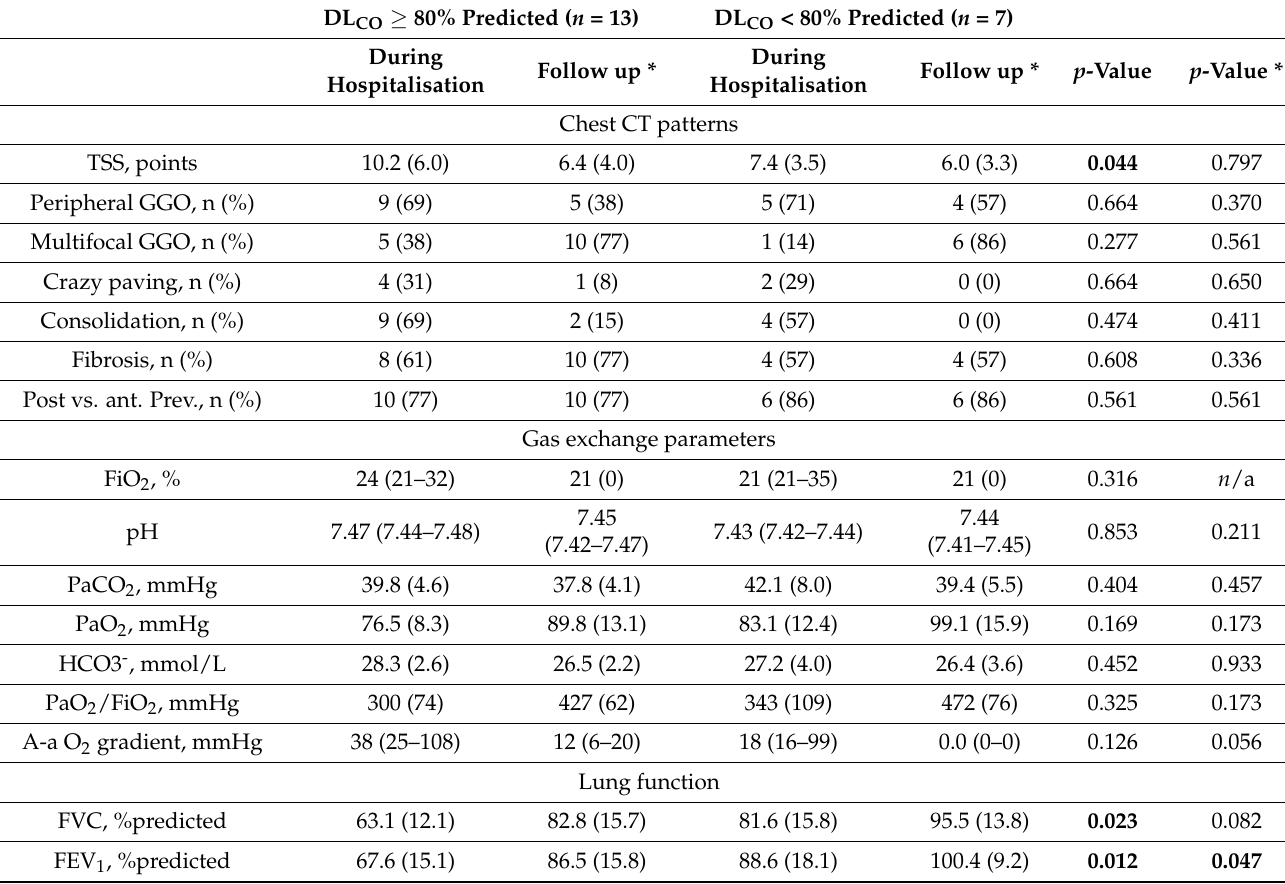
Table 4. Clinical and functional characteristics during hospitalization and at follow up in patients with DLCO ≥ 80% predicted and DLCO < 80%